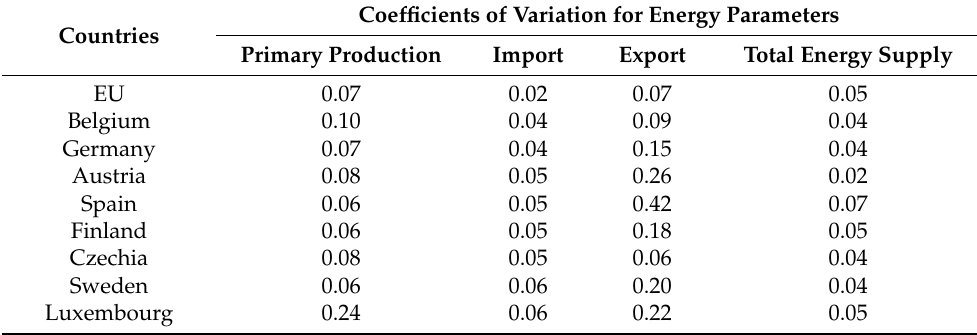
Table 2. Coefficients of variation for energy parameters in EU countries in 2008–2019. Coefficients of Variation for Energy Countries